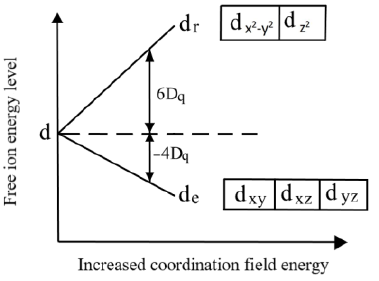
Figure 8. Splitting of 5 d orbital energies in the octahedral coordination field.